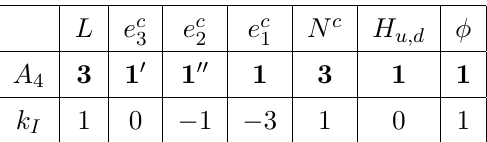
Table 2 . A natural A 4 model of leptons with a weighton (cid:30) . Note that each supermultiplet has a modular weight (cid:0) k I